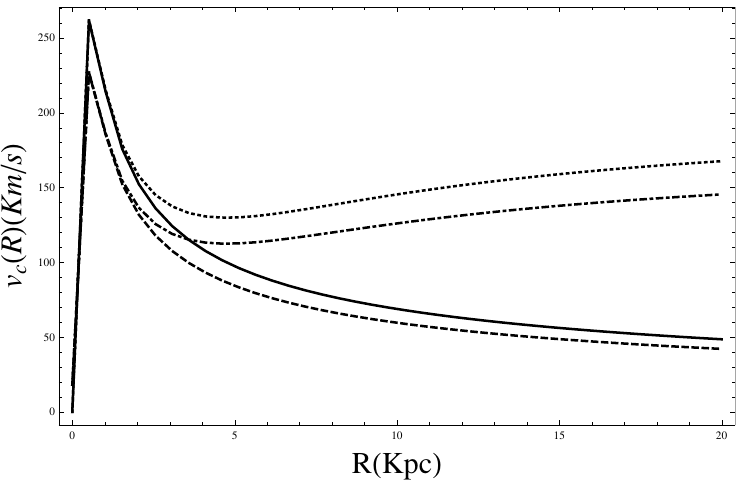
Figure 2. The rotation curve induced by bulge component (first line of Equation (88)): GR (dashed line), GR + DM (dashed and dotted line), FOG (solid line) and FOG + DM (dotted